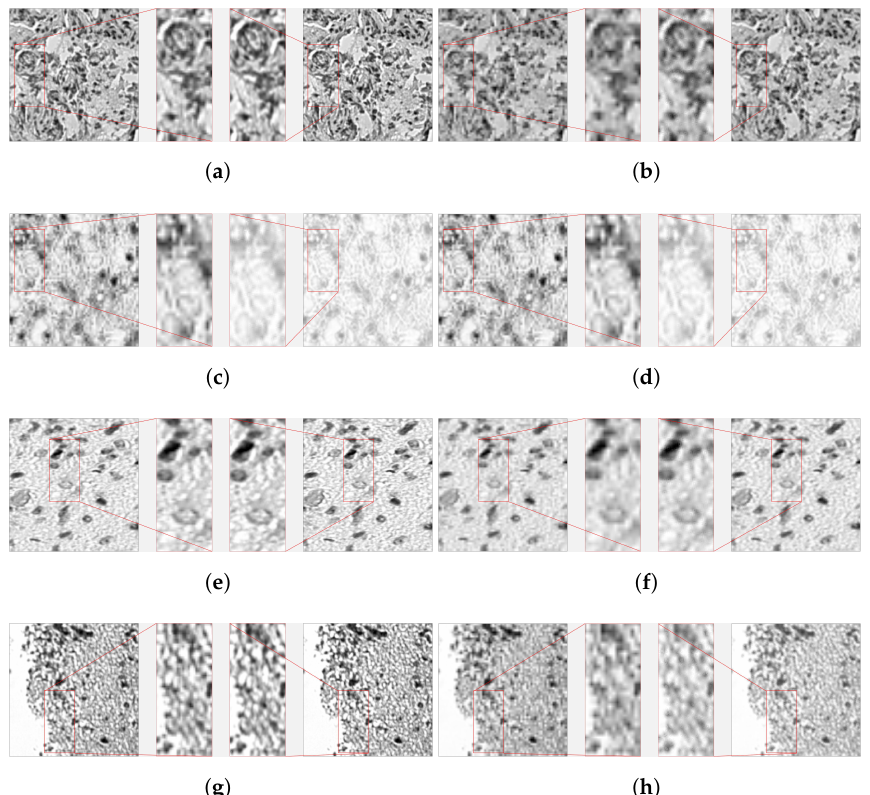
Figure 12. Visual quality inspection for Sequences 2 to 5 , and N = 25. The interpolated image and its corresponding zoom can be found on the left-hand side ; instead, on the right , the super-resolved image with its zoom. ( a , c , e , g ) capture sequences 2, 3, 4, 5 respectively for EF = 2. Results for EF = 4 is presented in ( b , d , f , h ), at their right side. Table 3. Quantitative assessment results of the proposed SR algorithm versus interpolation for se- quences 2 to 5. ↑ SAM represents the gain of the proposed algorithm in SAM with respect to a bi-linear interpolation. Five executions of the same program have been carried out to confirm the duration. SAM vs. ↑ SAM Execution